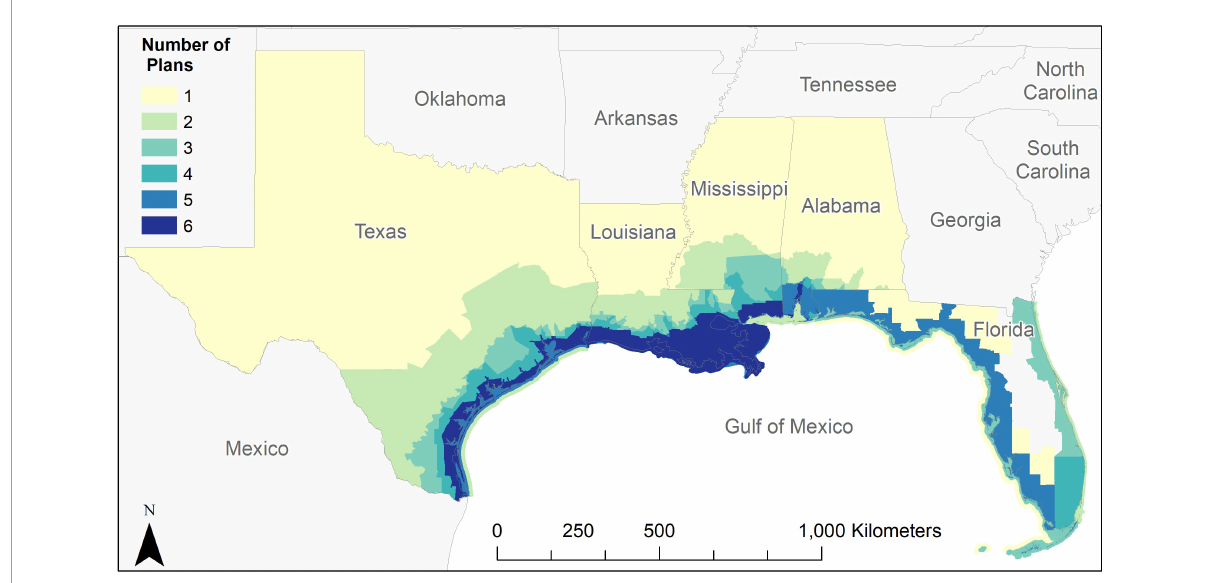
FIGURE1 Management plans often overlap in geographic scope, presenting managers with the challenge of considering multiple priorities in decision-making. Because restoration projects funded by the RESTORE Council focus primarily on coastal and offshore areas of the Gulf of Mexico region, management plan content considered for this project was narrowed in geographic scope to the coastal areas shown on the map. The darker blue areas on the map indicate locations within our study area which all selected management plans